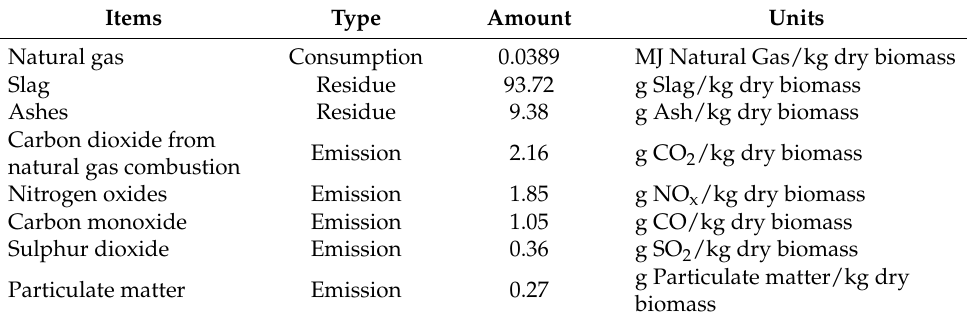
Table 3. Biomass power plant consumptions, residues and emissions.